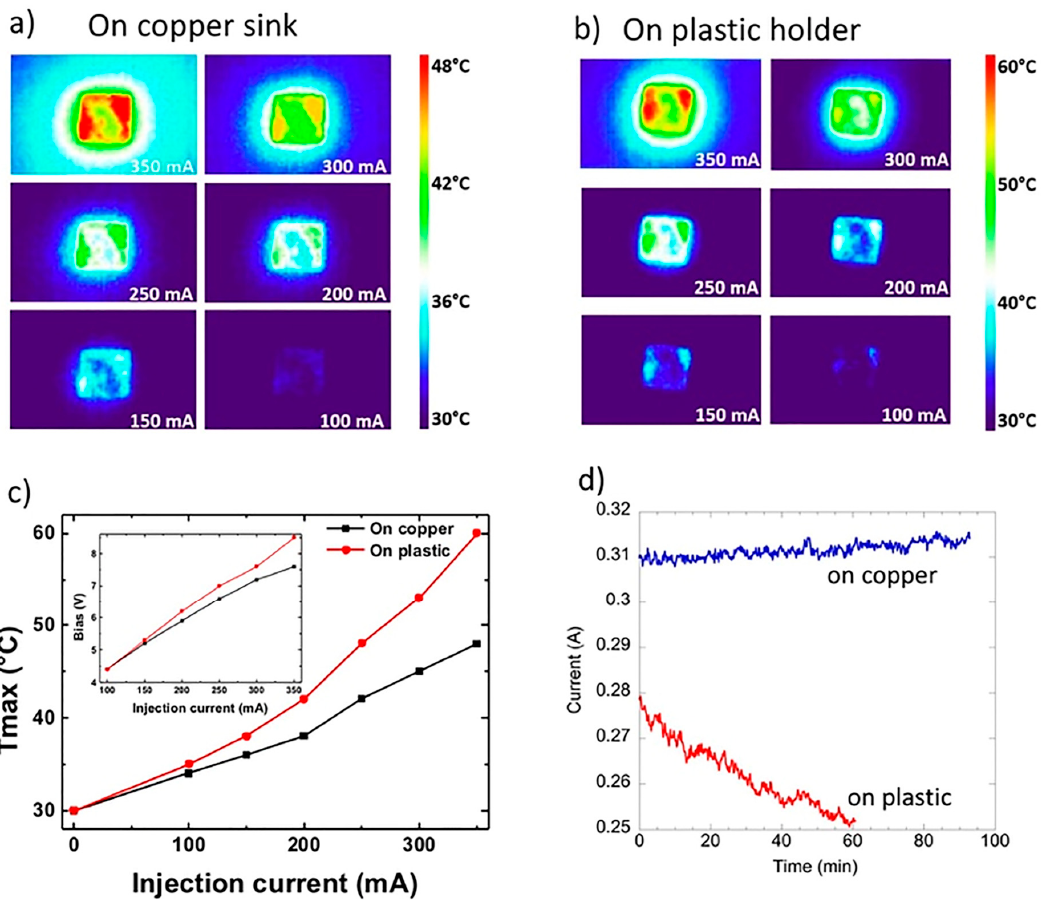
Figure 2. IR camera images of NW LED operating under different injection currents mounted on ( a ) copper heat sink and ( b ) plastic holder; ( c ) evolution of maximal temperature with injected current on two holders (inset shows bias for same injected current depending on holder type); ( d ) variation of current with time when forward LED bias was fixed at 7 V for the two holders.